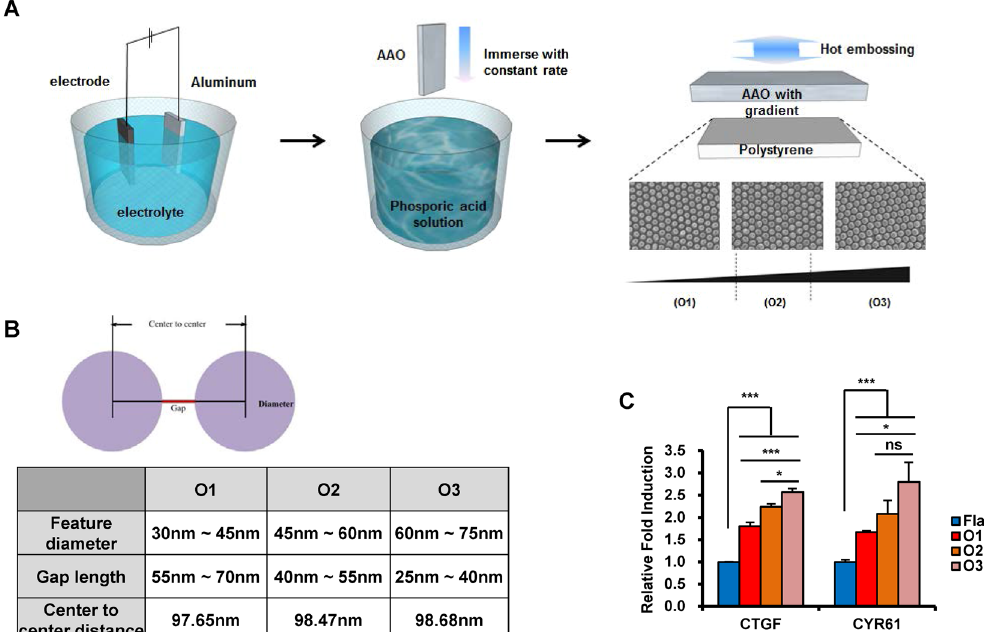
Figure 1. Preparation of nanopattern plates and screening of nanopattern surfaces with size gradients for TAZ target-gene induction. ( A ) An electrochemically polished aluminum foil was prepared in oxalic acidic condition. The anodizing process for fabrication of anodic aluminum oxide (AAO) was performed and the pore size gradient on AAO was produced using a tensiometer. Polystyrene plates with gradient nanopillar patterns were fabricated via the thermal imprint process. ( B ) Feature diameter, gap length, and center-to-center distance of O1, O2, and O3 nanopattern surfaces manufactured in the panel ( A ) are listed. ( C ) MSC were seeded on flat or nanopattern plates (O1, O2, and O3) and harvested after 48 hr. Transcript levels of CTGF and CYR61 were analyzed by quantitative real-time PCR. Asterisks mean statistical significance. n = 3, * p < 0.05, *** p < 0.005, ns = not significant,